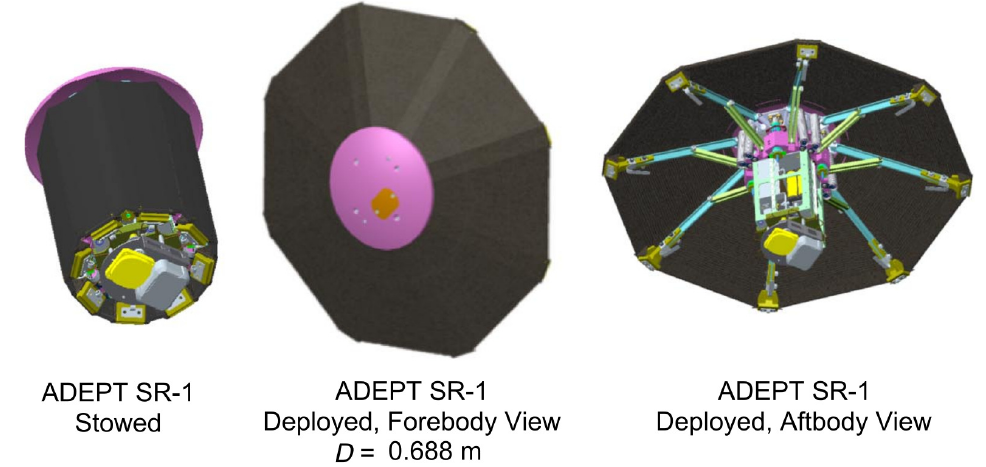
Figure 4. Stowed and deployed configurations of the ADEPT SR-1 flight test article. Reproduced from the work by Dutta et al./NASA [34]. The scaled-up version of the SR-1 article used in this study has a stowed diameter of 0.5 m and a deployed diameter of 1.5